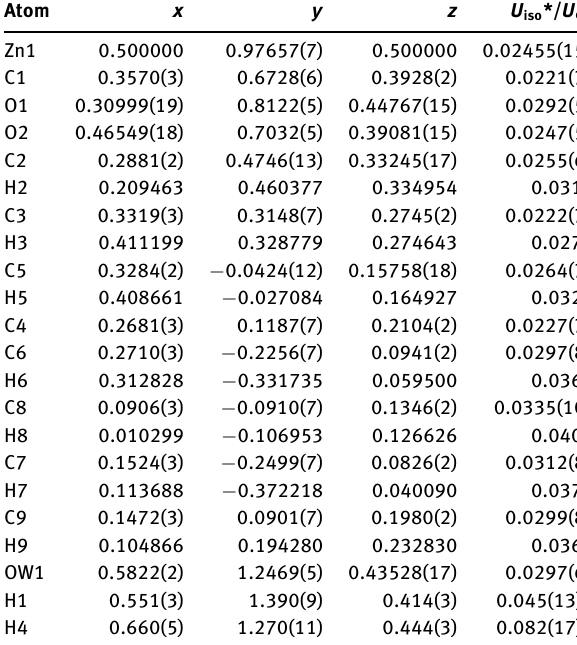
Table 2: Fractional atomic coordinates and isotropic or equivalent isotropic displacement parameters (Å 2